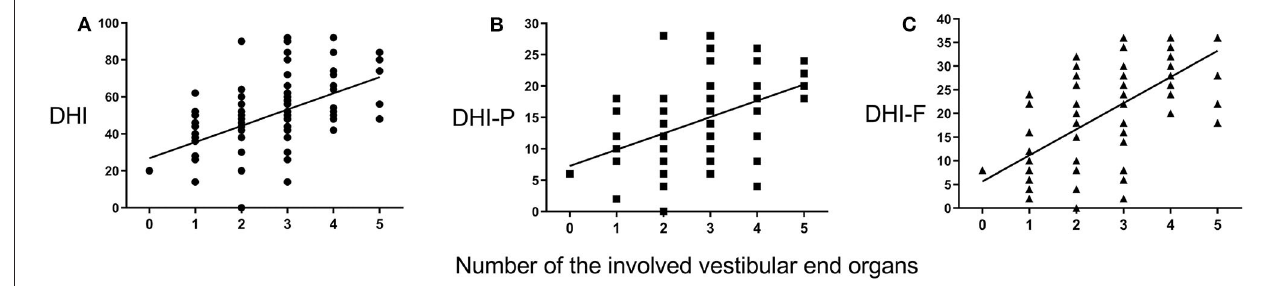
FIGURE 2 | Correlations between Dizziness Handicap Inventory (DHI) scores and number of involved vestibular end organs. The DHI (A) , DHI-P (B) , and DHI-F (C) scores positively correlate with the number of involved vestibular end organs.